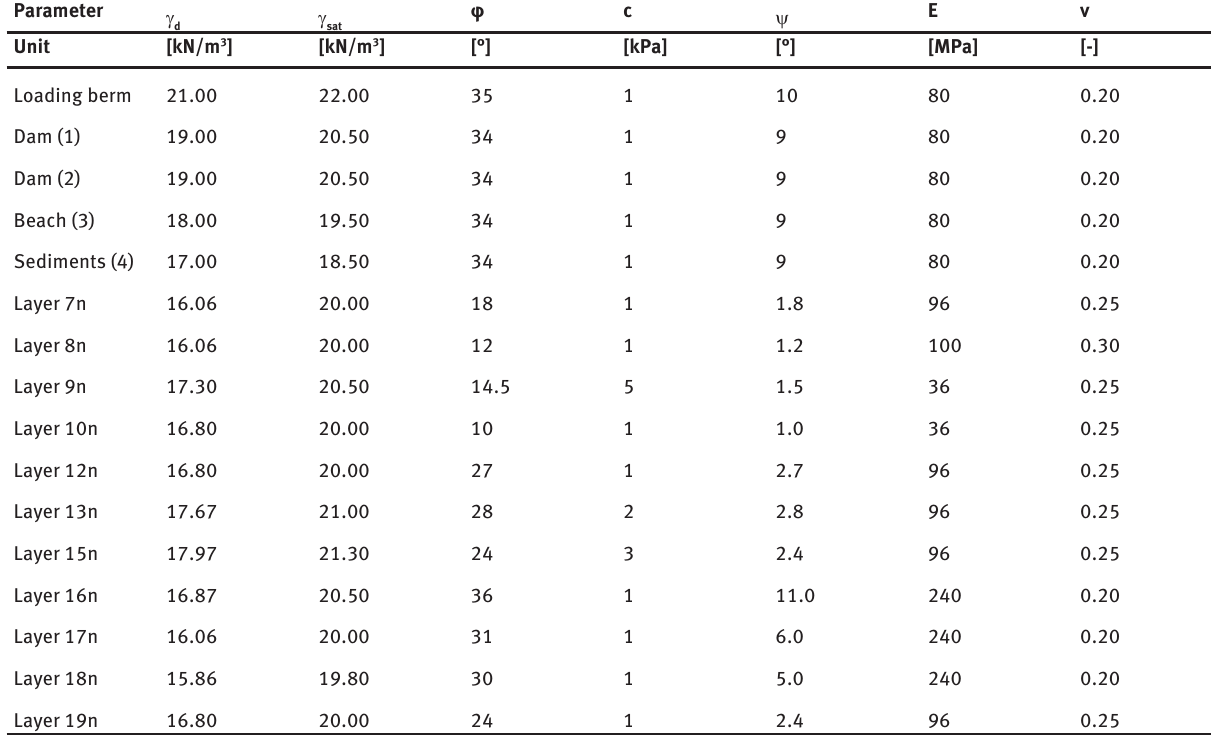
Table 2: Geotechnical parameters of the layers used in the calculations. Parameter g g d sat